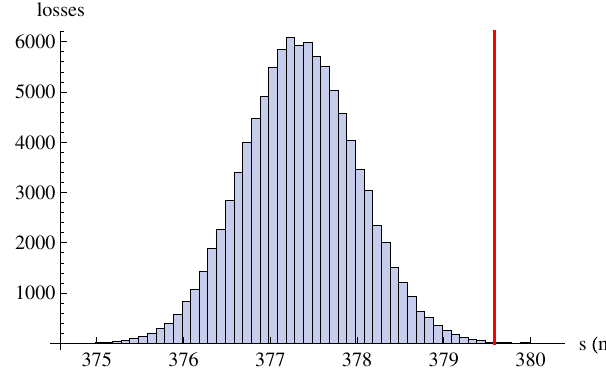
FIG. 5. The on-momentum horizontal (cid:2) function downstream of IP2 compared with the off-momentum ~ (cid:2) , calculated as described in the text (top), and the periodic dispersion function D shown together with the locally generated dispersion d (bot- tom). The dashed vertical line indicates the central loss position of the BFPP particles, close to the first maximum of the disper-